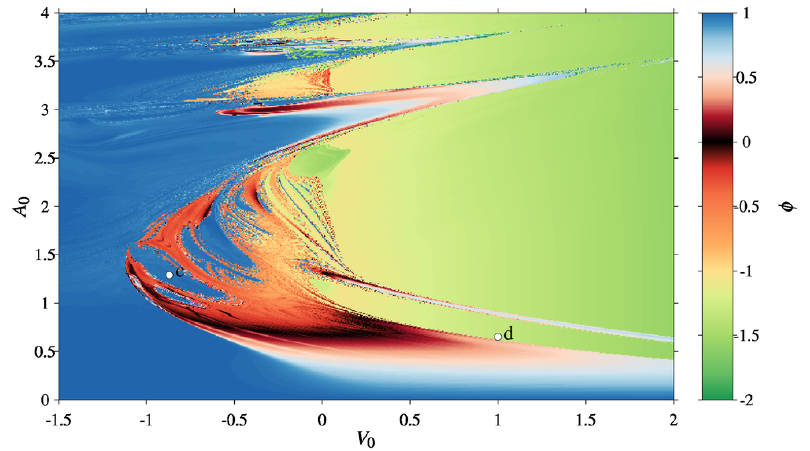
Figure 10 . Minimal value of (cid:30) (0 ; t ) for (cid:11) = 0 :